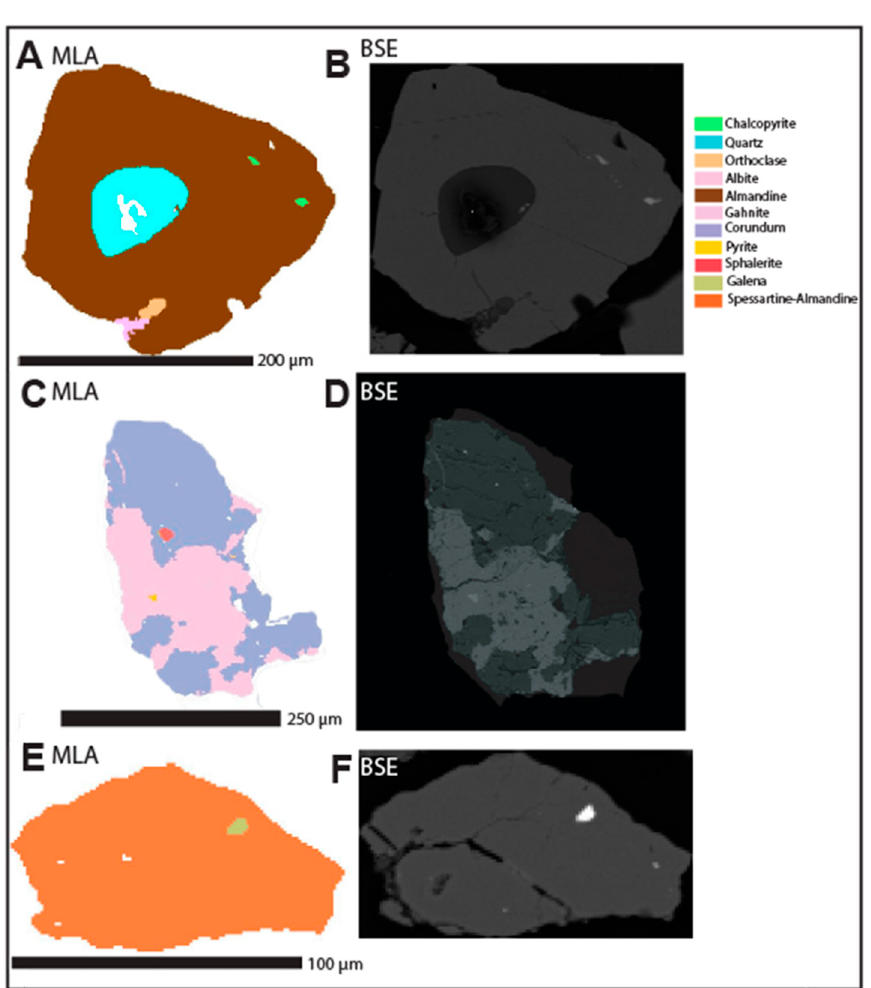
Figure 9. Mineral liberation analysis (MLA) and backscatter emission (BSE) images of mineral grains from till: ( A,B ) chalcopyrite inclusions (green) in almandine; ( C,D ) intergrown gahnite (pink) and corundum (blue); ( E,F ) galena inclusion (brown) in garnet. Note: scale bars below images vary.